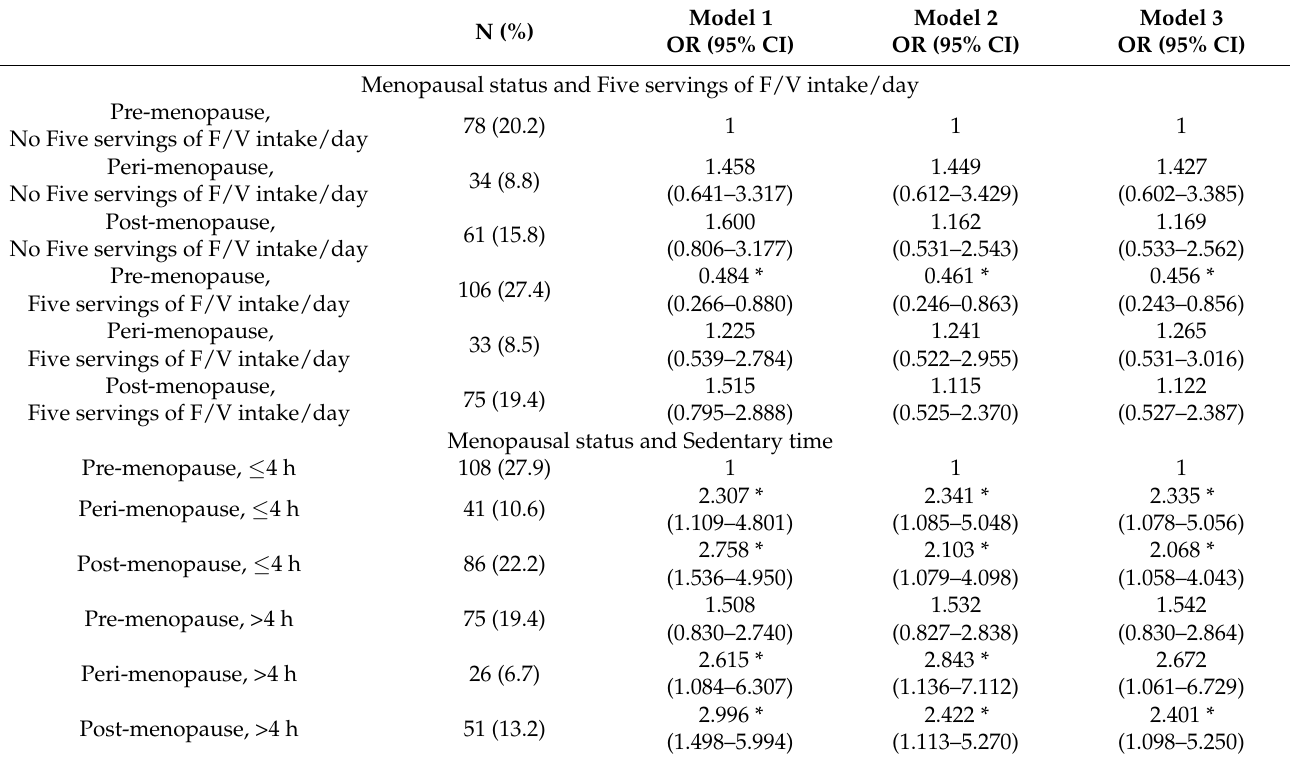
Table 4. Joint association of F/V intake or sedentary time and menopausal status with central obesity in women. Model 1 N (%) OR (95% CI)